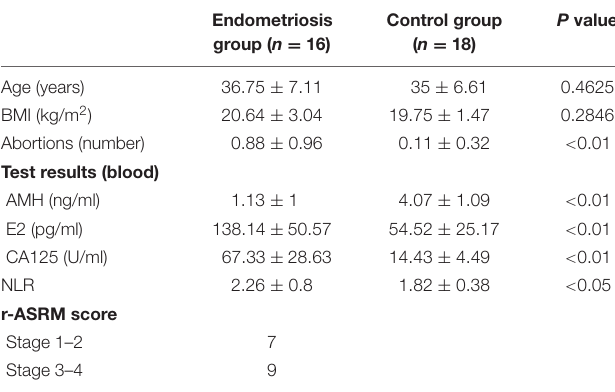
TABLE 1 | Basic characteristics of the included clinical study